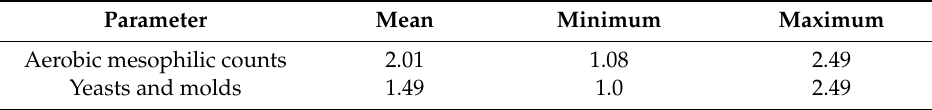
Table 4. Bacterial counts (log 10 cfu / 10 L) of 120 airborne dust